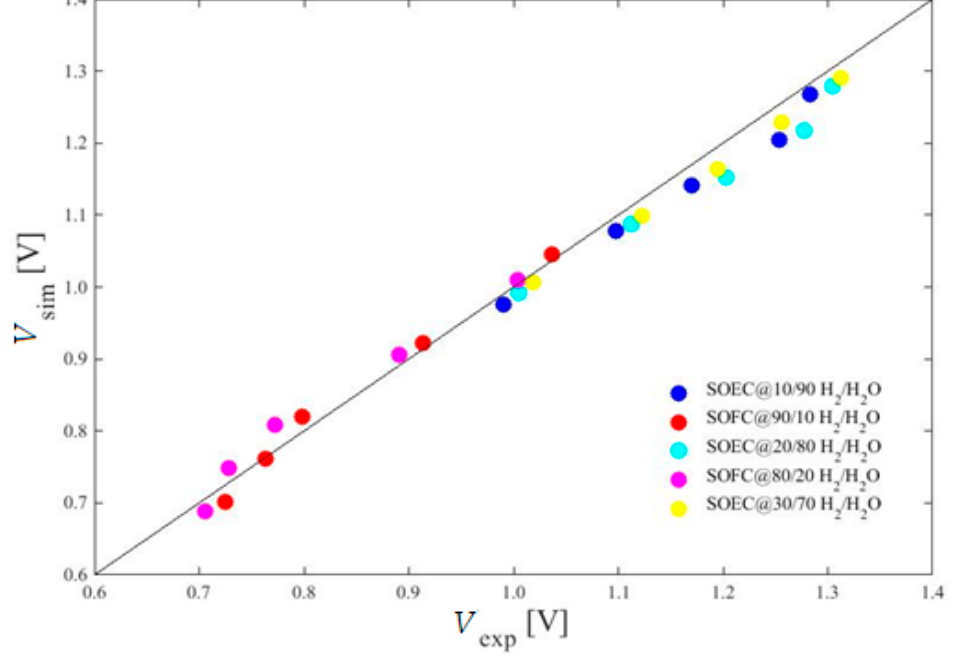
Figure4. Figure 4. Validation of a rSOC short stack electrochemical performance though 2D not-isothermal modeling.